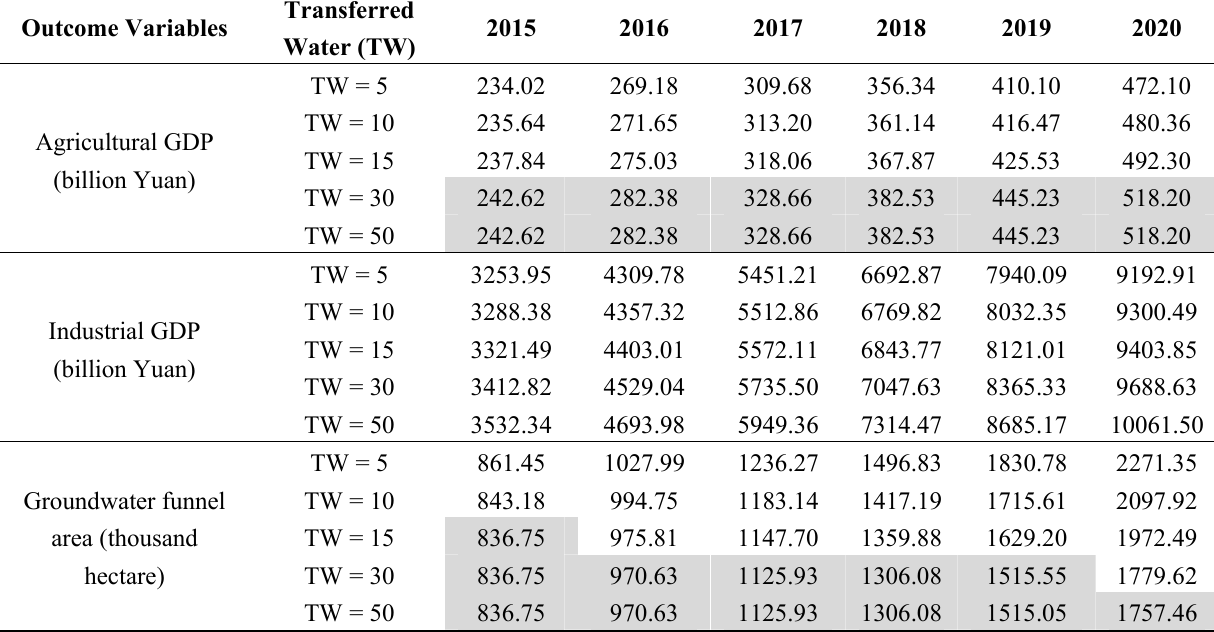
Table 2. Outcomes as water quantity changes,